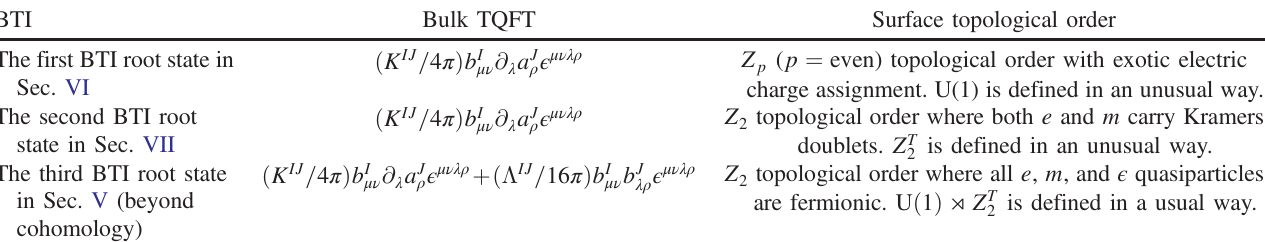
TABLE I. A brief summary of main results in Secs. V – VII. As in the 1D chiral Luttinger liquid theory, which can be derived by putting Chern-Simons action on a 2D disk with a 1D boundary, the surface of each BTI root state is also rigorously derived by putting the bulk field theory on an open 3D manifold with a 2D boundary. Symmetry transformations [both U(1) and time reversal Z T 2 ] are rigorously defined in the bulk. The first and second BTI root states are within the group cohomology classification and obtained by the changing definition of either U(1) symmetry or Z T 2 symmetry in the bulk. The third BTI root state is beyond group cohomology and its realization requires an addition of “ cosmological constant term ” b ∧ b term. More details (e.g., the integer matrices K IJ , Λ IJ ) are present in the main text.